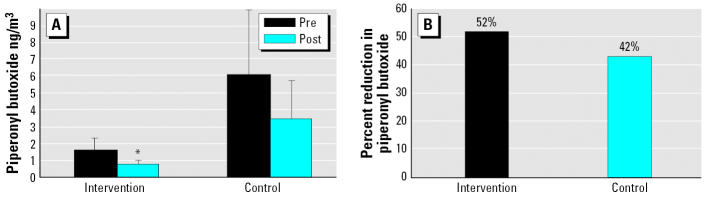
Piperonyl butoxide in 2-week integrated air samples. (A) Changes in mean (± SE) piperonyl butoxide levels in 2-week integrated indoor air samples collected over 2 weeks before and 2 weeks after the intervention. Intervention (n = 23), control (n = 24). (B) Percent reduction in piperonyl butoxide levels between 2-week integrated indoor air samples collected over 2 weeks before and 2 weeks after the intervention. Intervention (n = 23), control (n = 24). Comparison of differences in percent reduction in piperonyl butoxide levels between the intervention and control groups, group t-test, p = 0.3) (B).*Wilcoxon signed-rank test, p = 0.016.